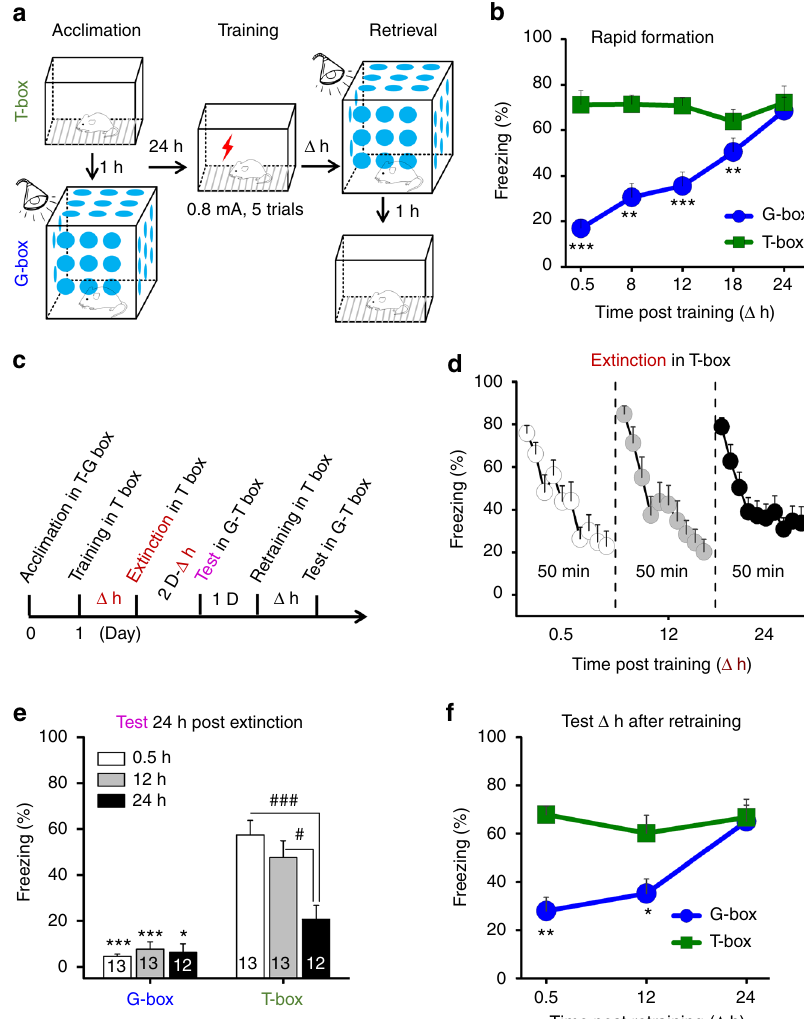
Fig. 1 Formation and extinction characteristics of generalization. a Schematic of fear memory in the training box (T-box) and generalization in a non- training similar box (G-box), measured at Δ h after fear conditioning. b Generalization developed gradually in G-box over 24 h ( n = 8 per group, but n = 9 at 18 h). c Generalization extinction paradigm. d Extinction curves in the separate groups by exposing into T-box for 50 min. e Generalization was disrupted in all groups, but fear memory was largely impaired at 24 h extinction after fear conditioning. f Retraining after extinction resulted in gradual reformation of generalization over 24 h (0.5 h, n = 6; 12 h, n = 7; 24 h, n = 8). Statistical comparisons are performed by using repeated two-way ANOVA (*contrast effects, G-box vs. T-box; # parameter estimates, between T-box groups); * P < 0.05, ** P < 0.01, *** or ### P < 0.001. Error bars,